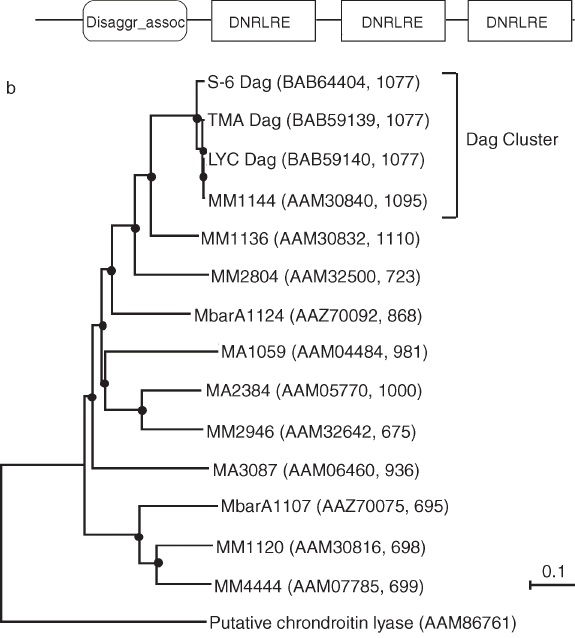
Figure 3. (a) Schematic structure of disaggregatase. Disaggr_assoc (200 residues) and DNRLRE (disaggr_repeat; 181 or 185 residues) domains are conserved motifs with Pfam accession nos.of PF08480 and PF06848, respectively. (b) Phylogenetic relationships between disaggregatase and the hypothetical proteins containing both of disaggr_assoc and disaggr_repeat domains found in genomes of Methanosarcina mazei Gö1, M. acetivorans C2A and M. barkeri fusaro based on amino acids sequences. Black circle at branch points indicates bootstrap value greater than 500 out of 1000 replicates. Chondroitin lyase (GenBank accession no. NP_670510) was used as an outgroup.The scalebarrepresents0.1 substitutionsperaminoacid. Sequences are shown with their ORF numbers (MM, M. mazei Gö1 ORF; MA, M. acetivorans C2A ORF; MbarA, M. barkeri fusaro ORF). Protein ID and number of amino acid residues of protein are shown in